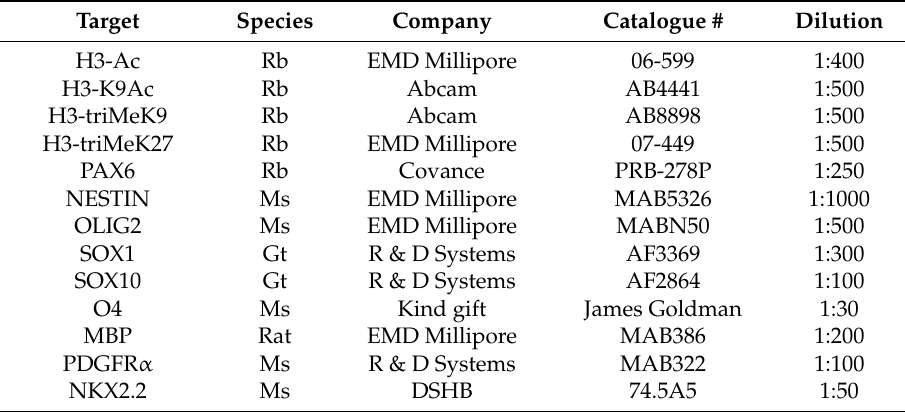
Table 2. Antibodies used in immunofluorescent